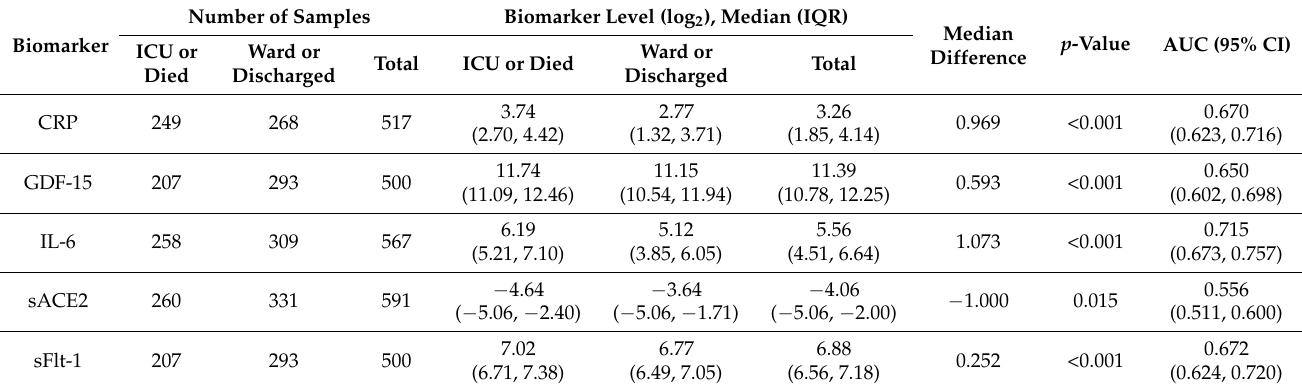
Table 5. Overview of differences in biomarker levels between patients with SARS-CoV-2 infection who were admitted to the ICU or died (Groups 3 and 4) and patients with SARS-CoV-2 infection who were admitted to the ward or discharged (Groups 1 and